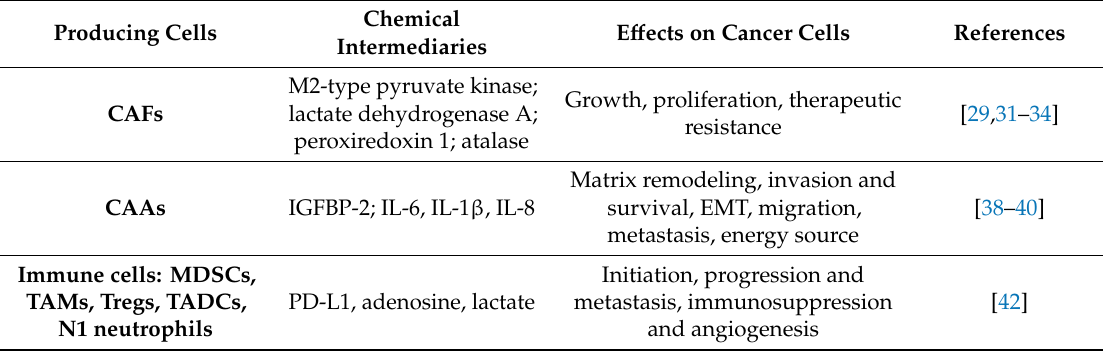
Table 1. Major metabolic chemical intermediaries involved in communication between stromal and cancer cells and a synthetic view of their e ff ects on cancer